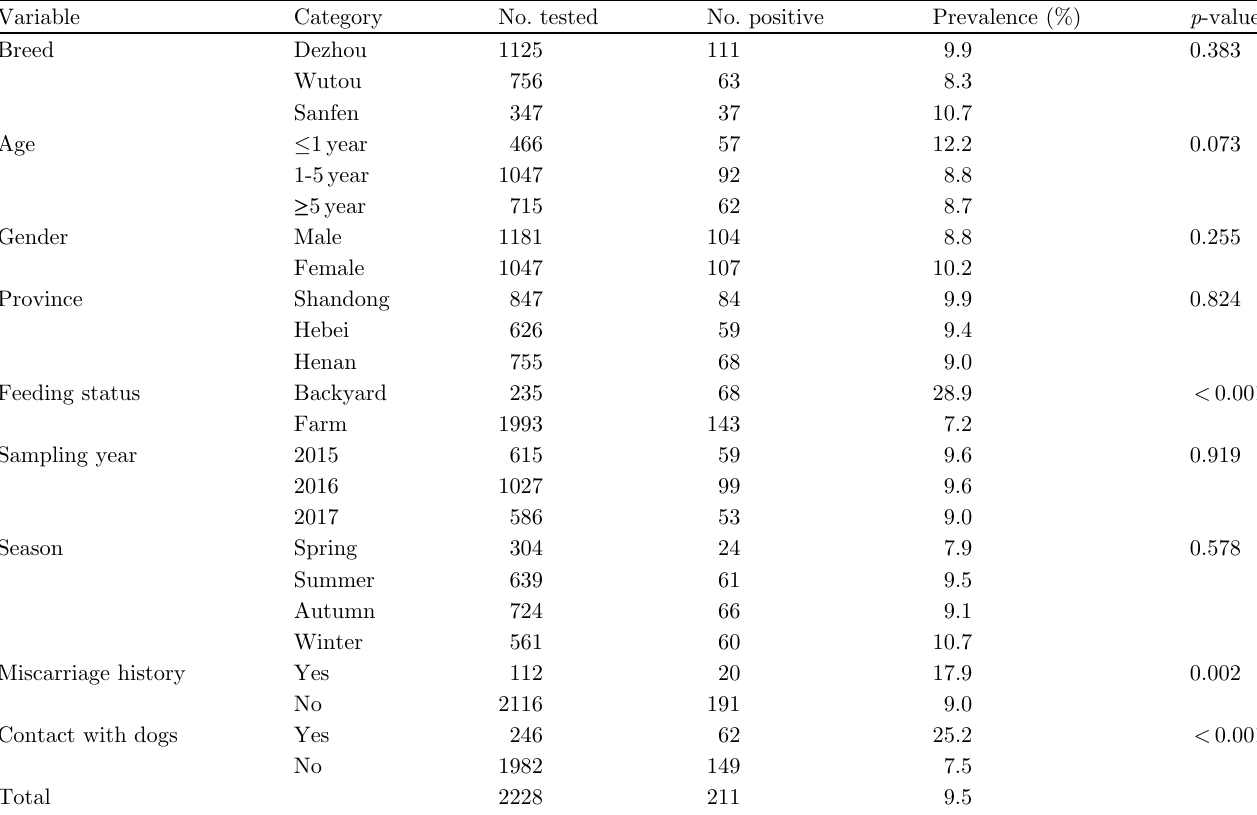
Table 1. General data for the 2,228 donkeys studied and seroprevalence of Neospora spp. infection. Variable